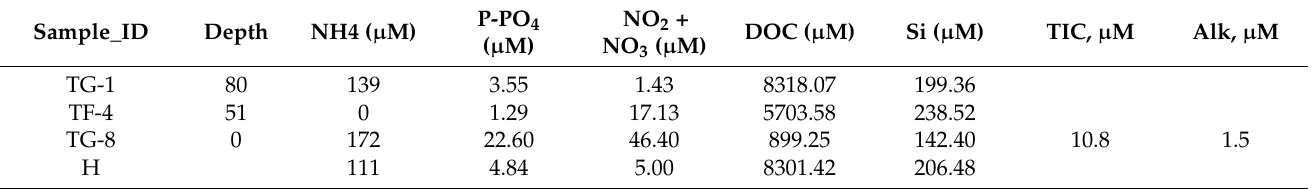
Table A3. Data on nutrient content in the pore water of bottom sediments in Templefjord in front of the river (TG-1) near the glacier (TF-4), in permafrost (TG-8), and in Longyearbean harbor (H) (June